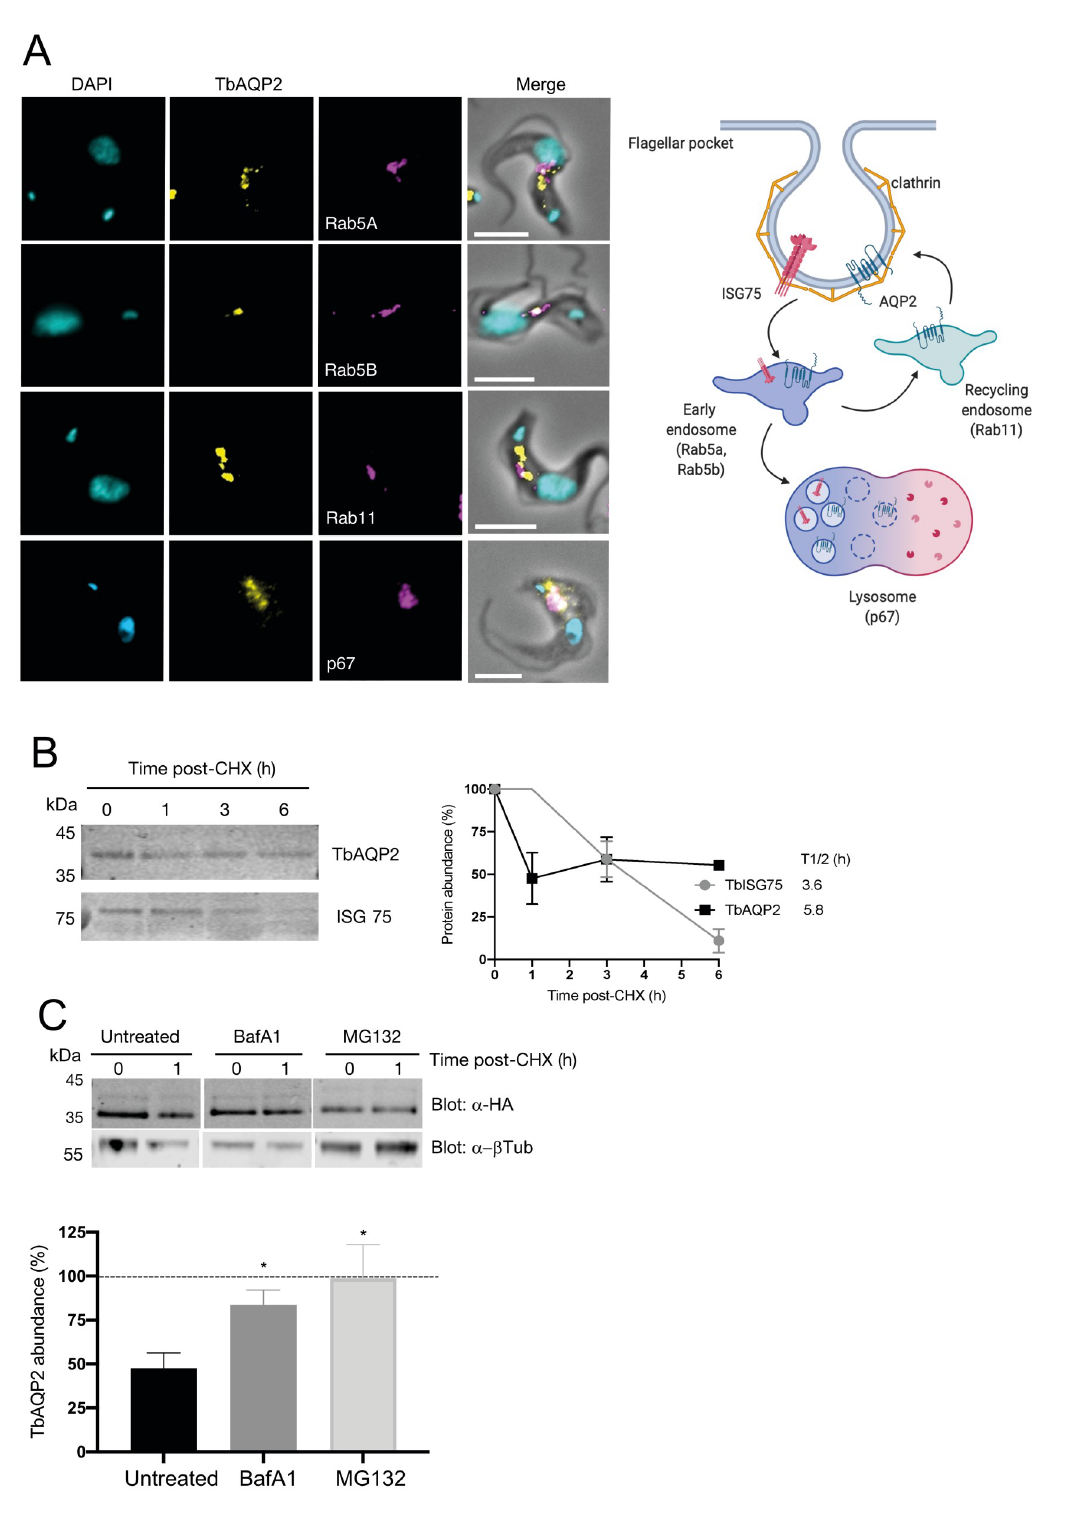
Fig 4. TbAQP2 transits through the endosomal compartment and is efficiently delivered and degraded in the lysosome. A) Cell lines expressing a tetracycline-regulated copy of 3xHA AQP2 (Alexa Fluor 488; yellow) were co-stained with anti-TbRab5a and